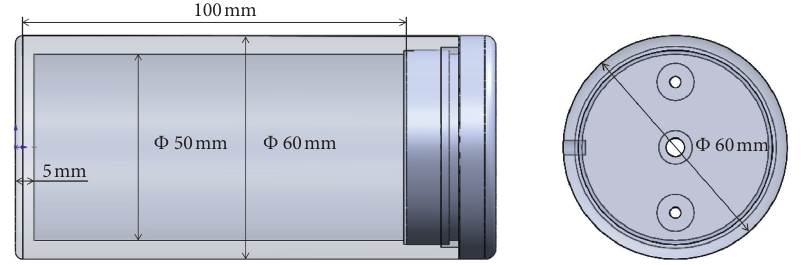
Figure 13: Small test cabin.